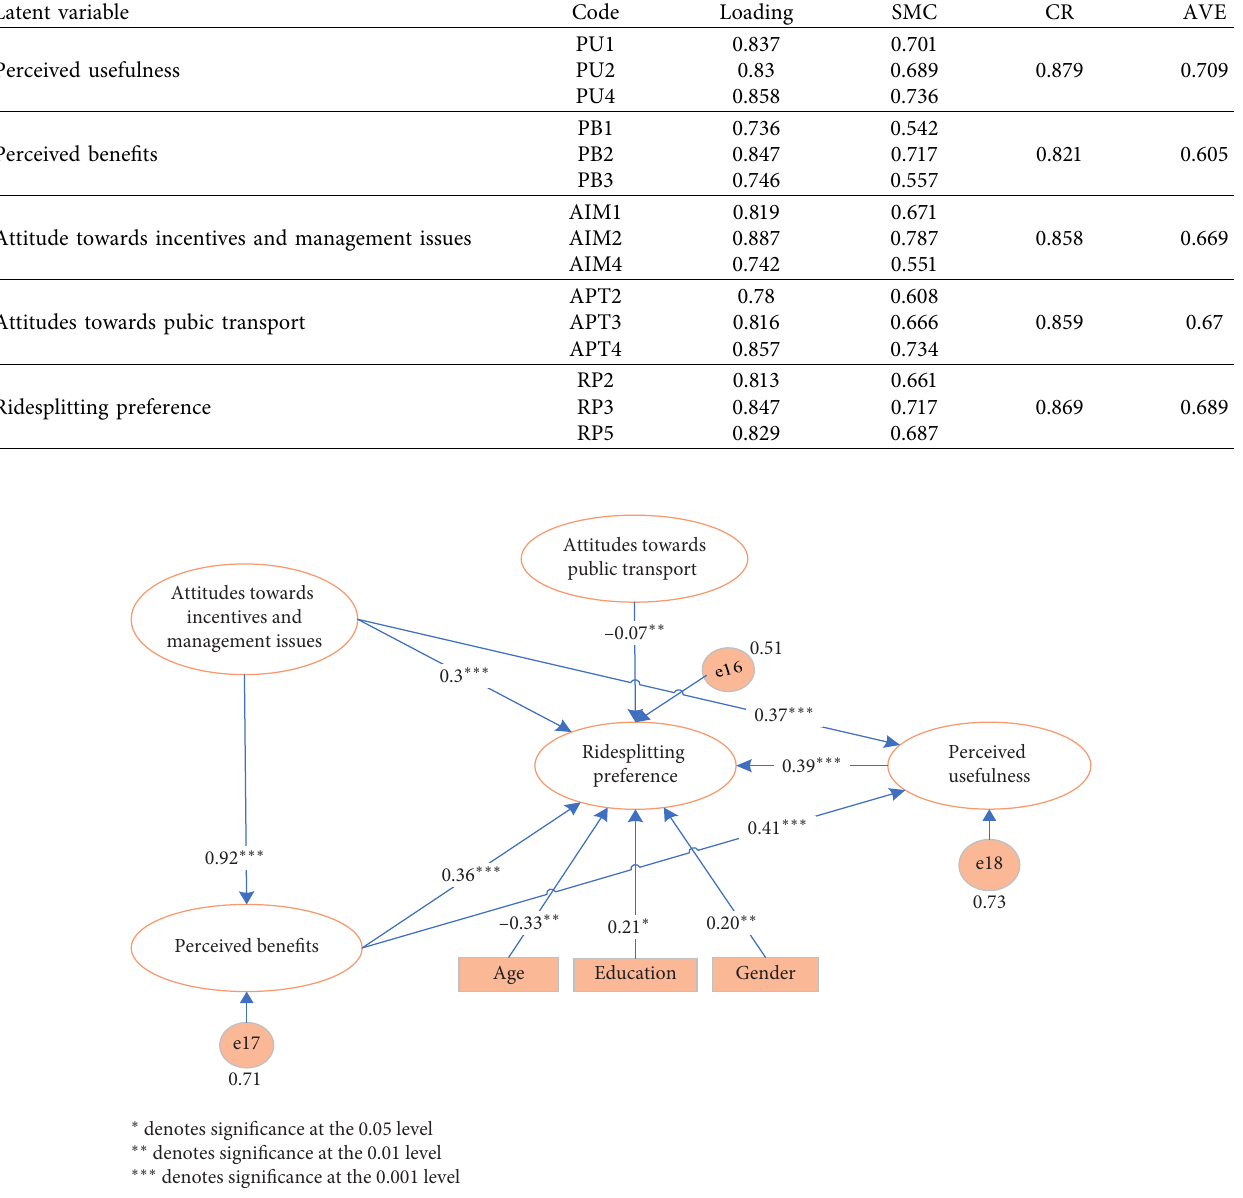
Figure 2: Estimate results of the structural equation model. ∗ denotes significance at the 0.05 level, ∗∗ denotes significance at the 0.01 level, ∗∗∗ denotes significance at the 0.001